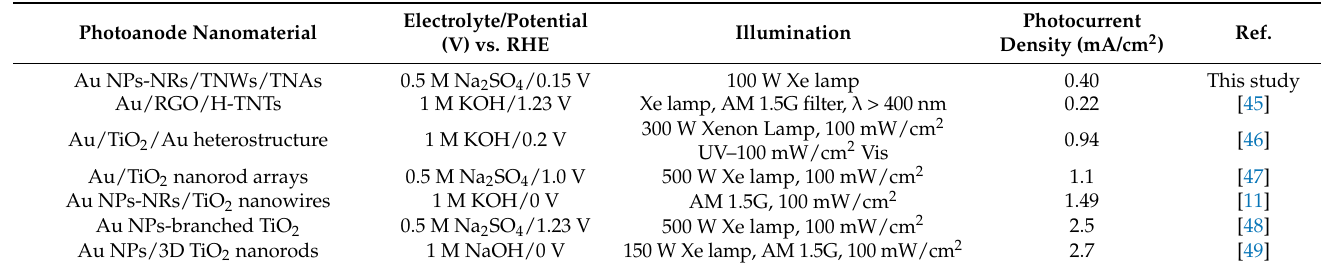
Table 1. Photocurrent density and photoelectrochemical measurement conditions of the optimal Au/TiO 2 -based photoanodes developed in this study and in the literature.